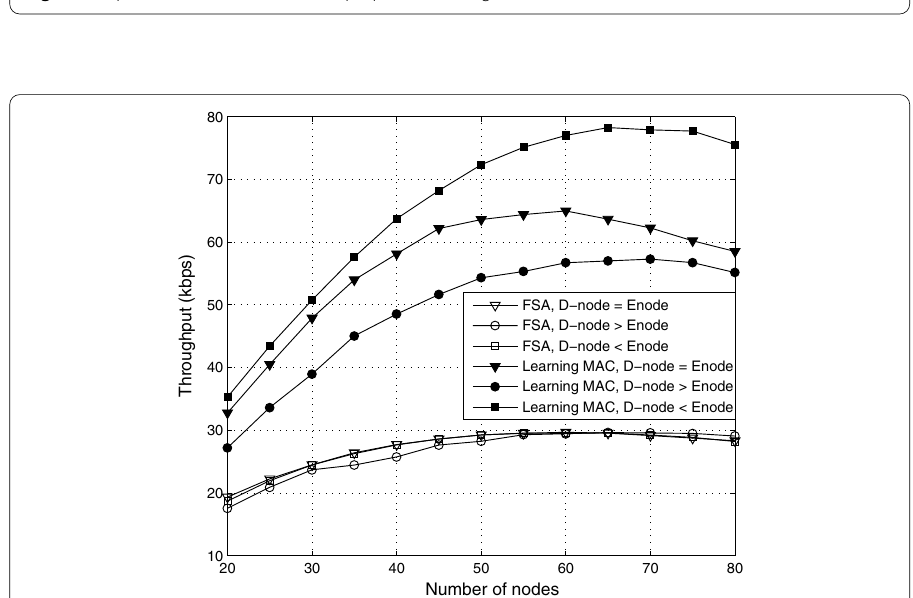
Fig. 6 The performance of FSA and the proposed learning MAC ( N